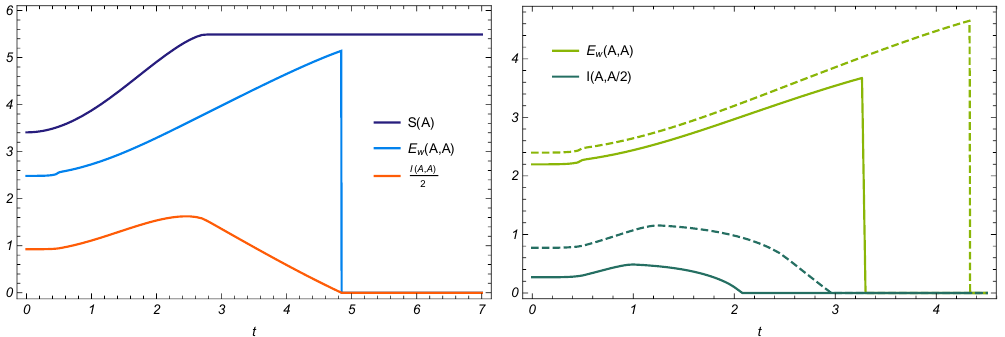
Figure 18 . Left : plot of the HEE, EWCS and half the HMI as a function of boundary time for ‘ = 5 : 5. Right : plot of EWCS( ‘ , ‘ ) and HMI( ‘ , ‘= 2) for ‘ = 4 (solid) and ‘ = 5 (dashed). Here we have set h = 1 and d =